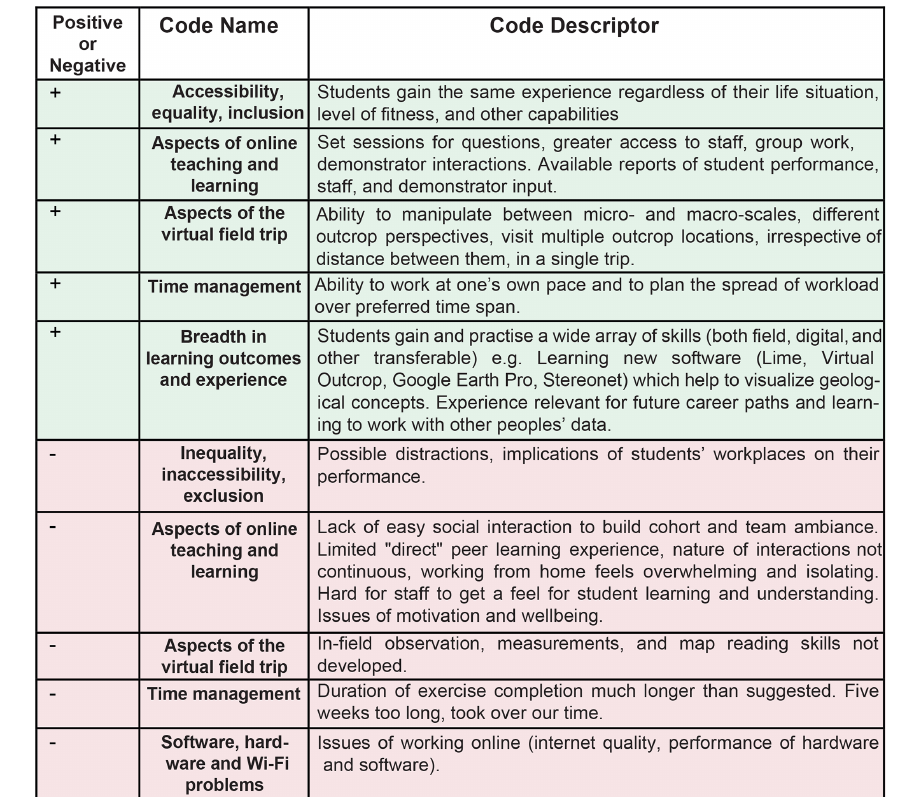
Table 1. Summary of codes and descriptors for the qualitative text analysis; the table is colour-coded to display the positive (green) and negative (red)